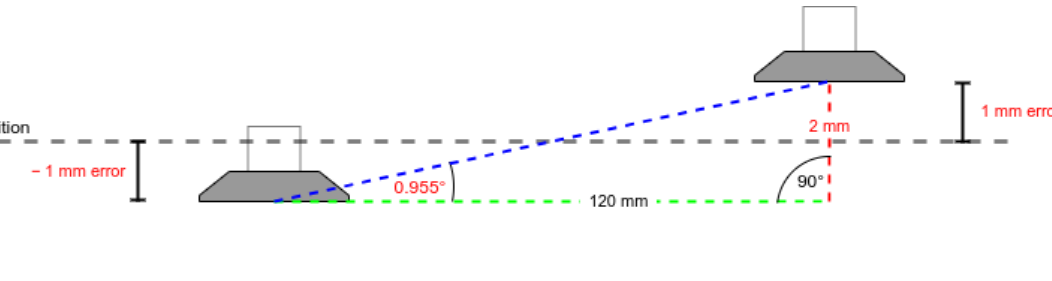
Figure 6. An illustration of the maximal depth and orientation errors.